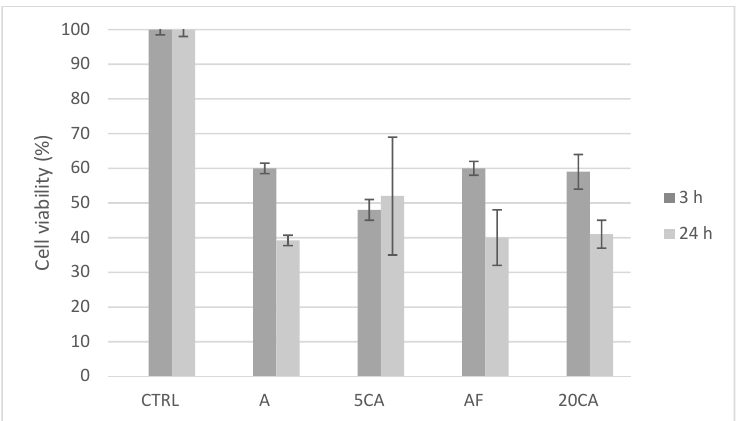
Figure 5. Effect of the four 3D printed hydrogel constructs on fibroblast cell viability. Cell viability was determined by resazurin assay at 3 h (dark gray lines) and 24 h (light gray lines) on the negative control (CTRL). The results are reported as means ± standard deviation of three independent measurements.